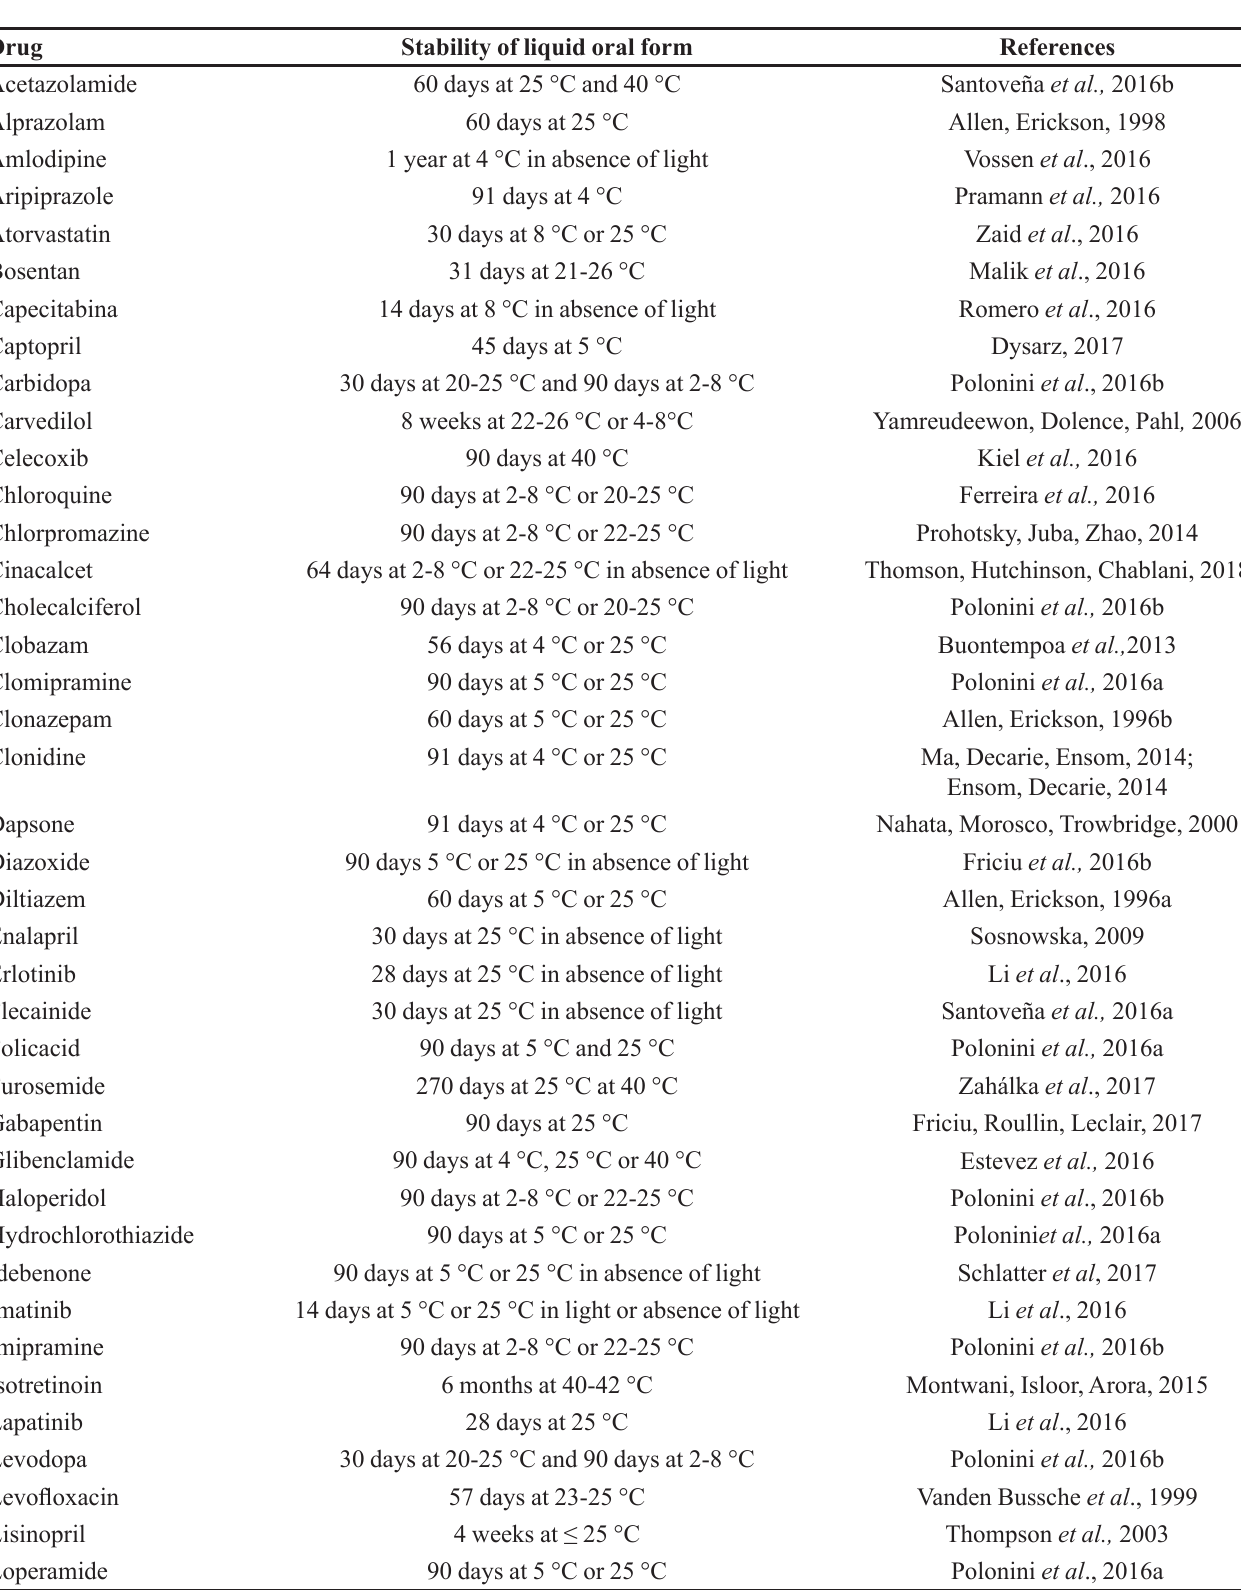
TABLE III - Extemporaneous oral liquid prepared from solid oral dosage forms commercially available